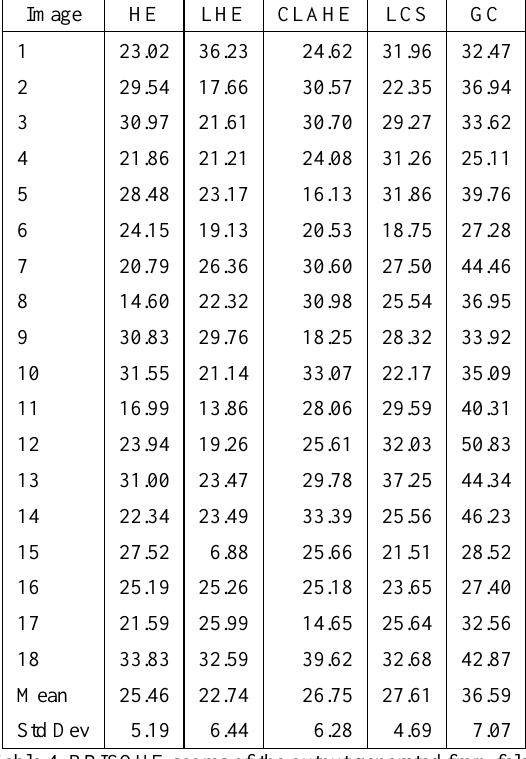
Table 4. BRISQUE scores of the output generated from false color post-flood Landsat images using five enhancement algorithms. Lower BRISQUE scores indicate higher output quality. Pair-wise comparison (one tailed, paired T-test) of the BRISQUE scores indicate that the output generated from each method was statistically different from the rest (Table 5). Output quality of LHE generated images are significantly different from those generated from other methods.